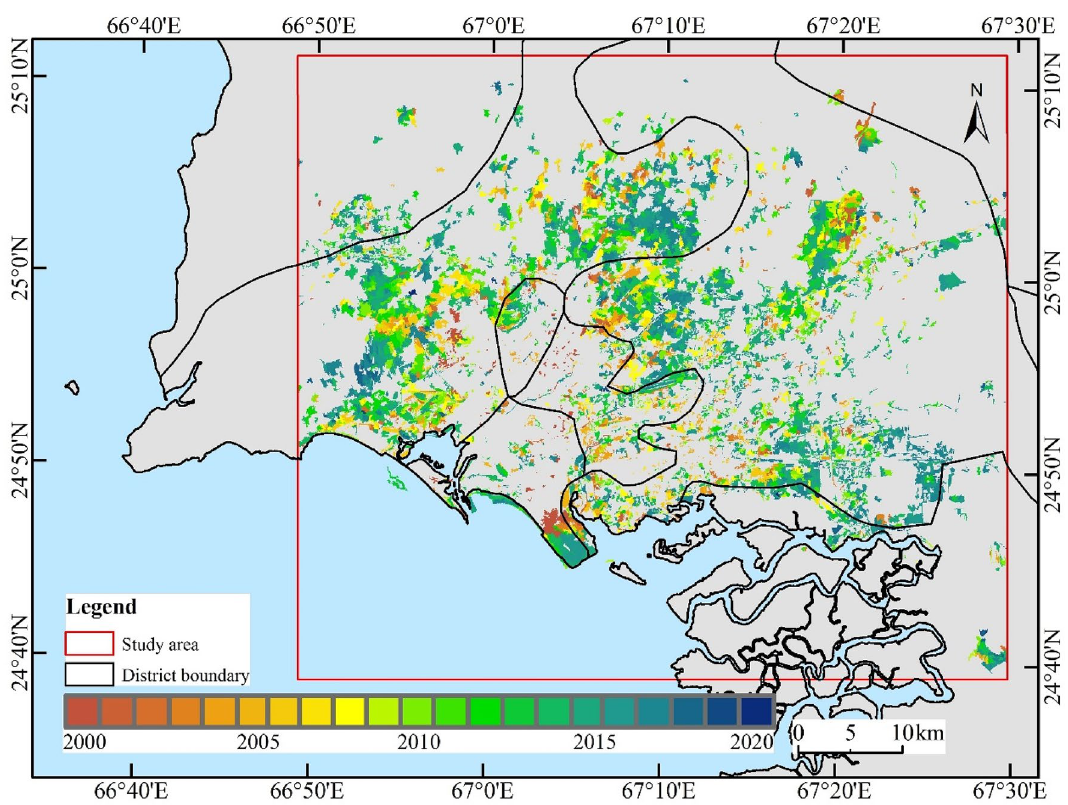
Figure 2. Interannual variation of urban expansion in Karachi. The map created in ESRI ArcMap 10.2 (https:// suppo rt. esri. com/ zh- cn/ produ cts/ deskt op/ arcgis- deskt op/ arcmap/ 10-2-2).